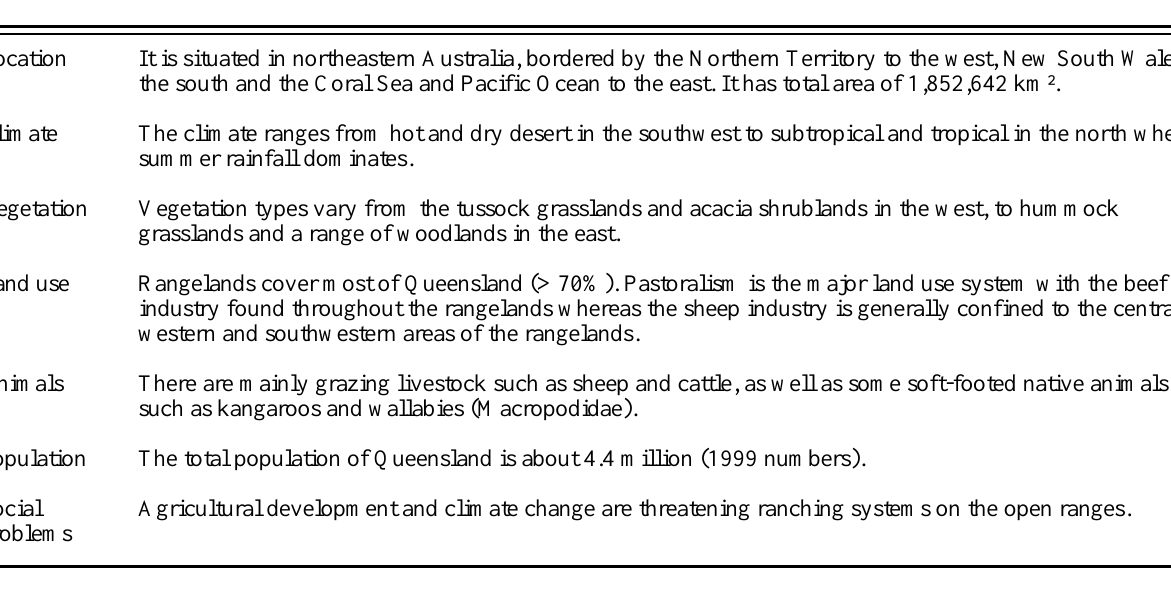
Table 6. General information on Queensland, Australia (Productivity Commission 2005, Richards and Lawrence